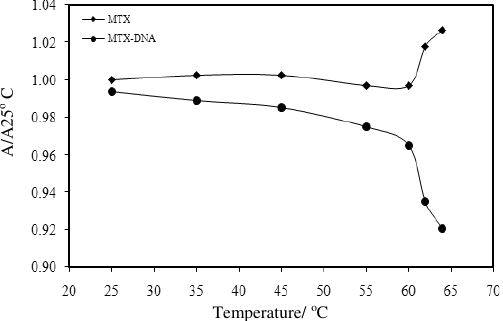
Figure 8. Melting curves for MTX in the absence and presence of DNA at 298 nm. Conditions: c = 10.0 µ mol L -1 , C = 55.3 µ mol L -1 in phosphate buffer (0.1 mol L -1 , MTX DNA pH 7.4) plus NaCl (0.1 mol L -1